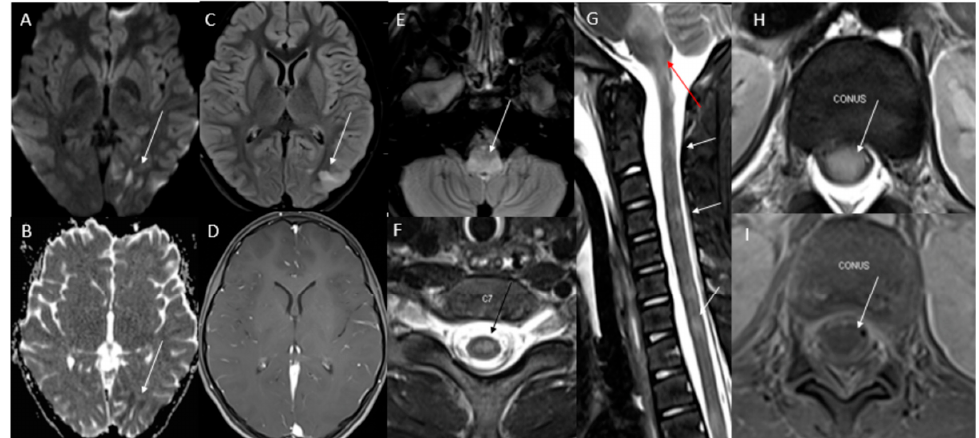
Figure 2. Repeat neuroaxis imaging shows increasing patchy restricted diffusion in left posterior temporal and occipital lobes (white arrows in images A,B ). Small area in left posterior temporal lobe which demonstrated restricted diffusion on prior MRI brain shows increasing T2 prolongation (white arrow in image C ). There is no perceivable enhancement (image D ). Repeat imaging showing dorsal medulla in the expected location of area postrema (white arrow in image E ). Axial T2 image through the lower cervical spinal cord demonstrates cord swelling and central cord T2 prolongation (black arrow in image F ). Sagittal STIR image of the cervical spine shows multifocal areas of T2 prolongation with cord swelling (white arrow in image G ) and is also noted in extensive T2 prolongation in the dorsal brain stem (red arrow image G ). Axial T2 image through the conus medullaris demonstrates T2 prolongation with cord swelling (white arrow in image H ) but without perceivable enhancement (white arrow in image I ).